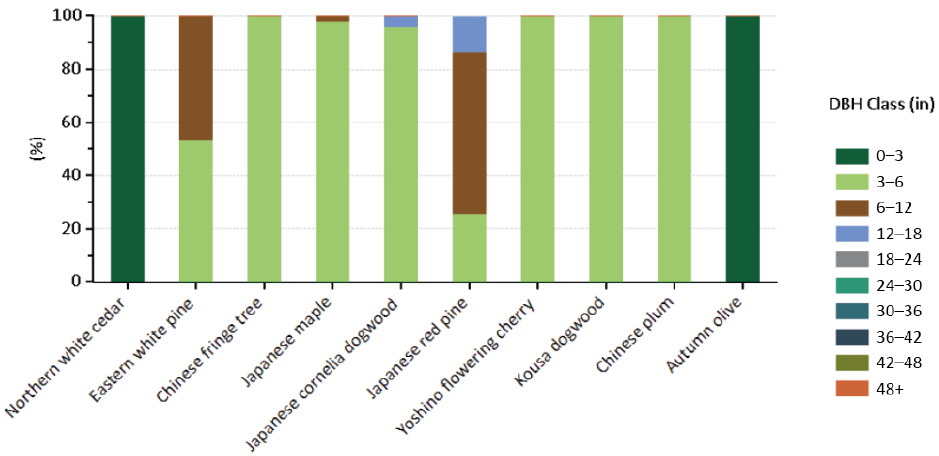
Figure 4. Species distribution by DBH class (top 10 most populated species in the project area).